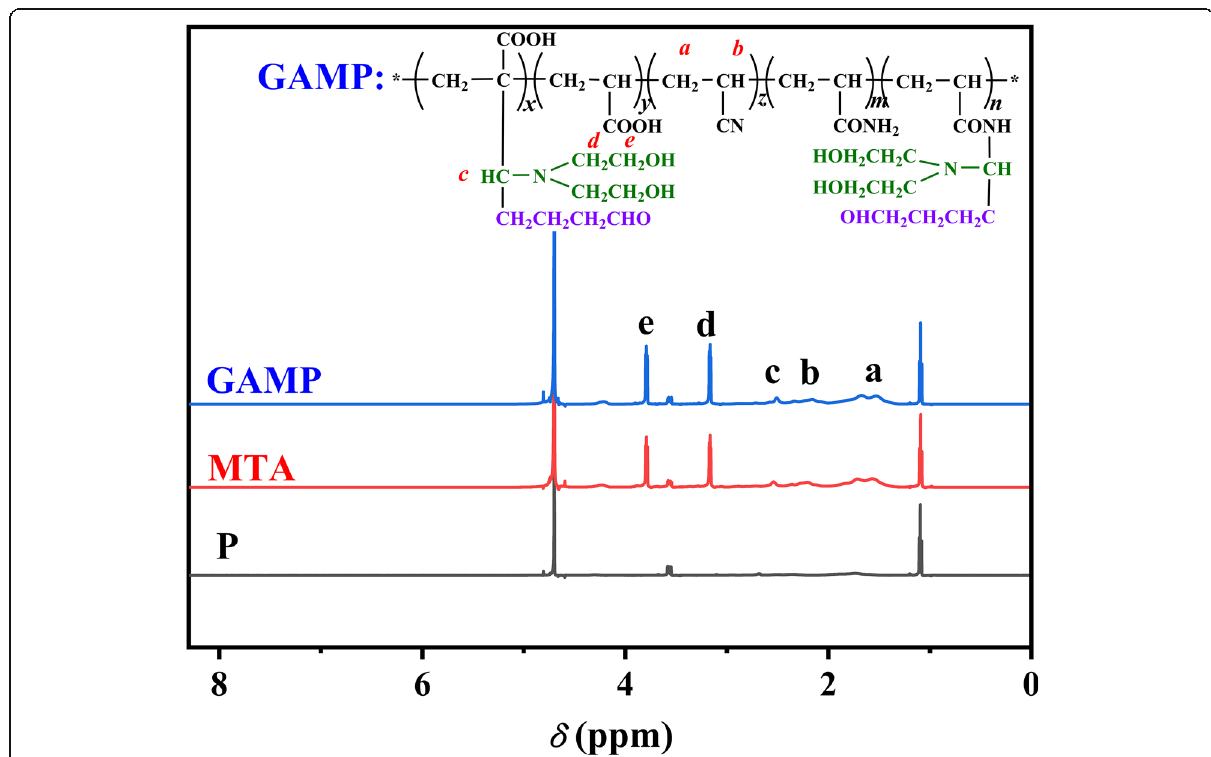
Fig. 3 1 H-NMR spectra of the P, GAMP and MTA